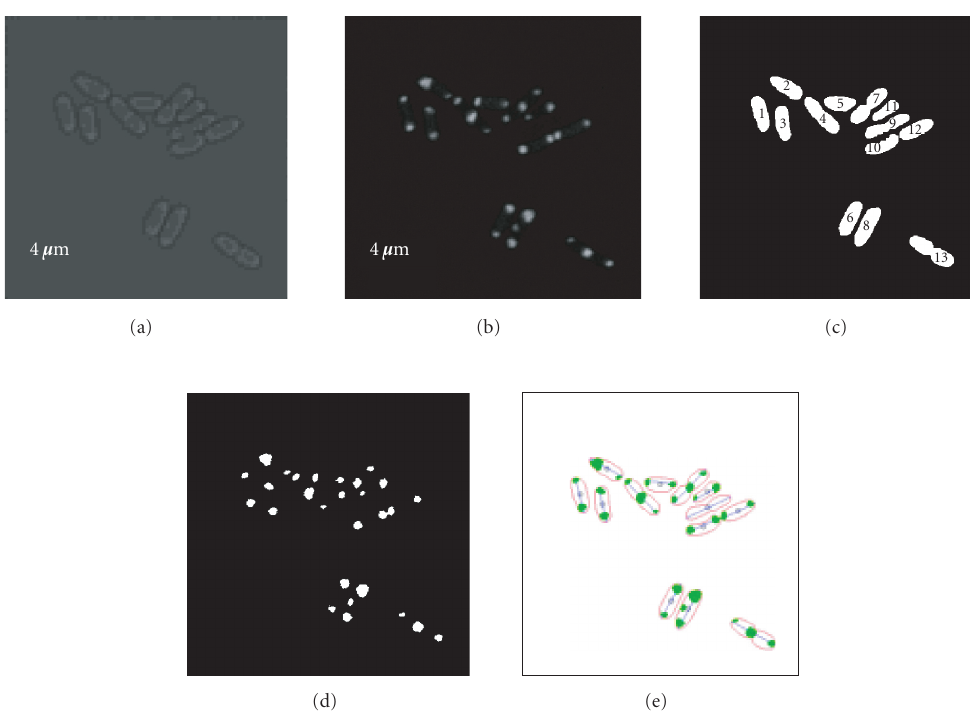
Figure 8: Image processing steps leading to a final pseudocolored image from DIC and fluorescence images of E. coli cells expressing a GFP-fusion protein. (a) Original DIC image. (b) Original fluorescence image. (c) Binary DIC image. (d) Binary GFP image before labeling. (e) Pseudocolored image showing cell boundaries (red), cell diameter (blue), sites of GFP-fusion protein localization (green), and the COG